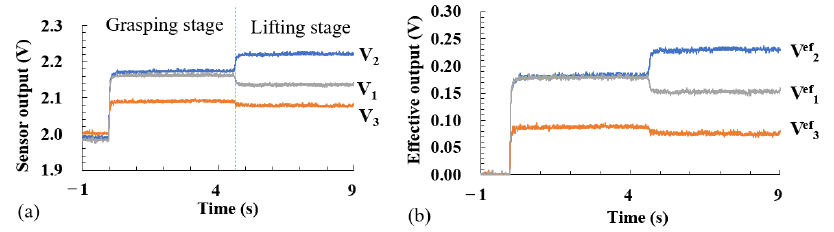
Figure 5. Oscillogram of the tactile sensor: ( a ) sensor outputs, ( b ) effective outputs.